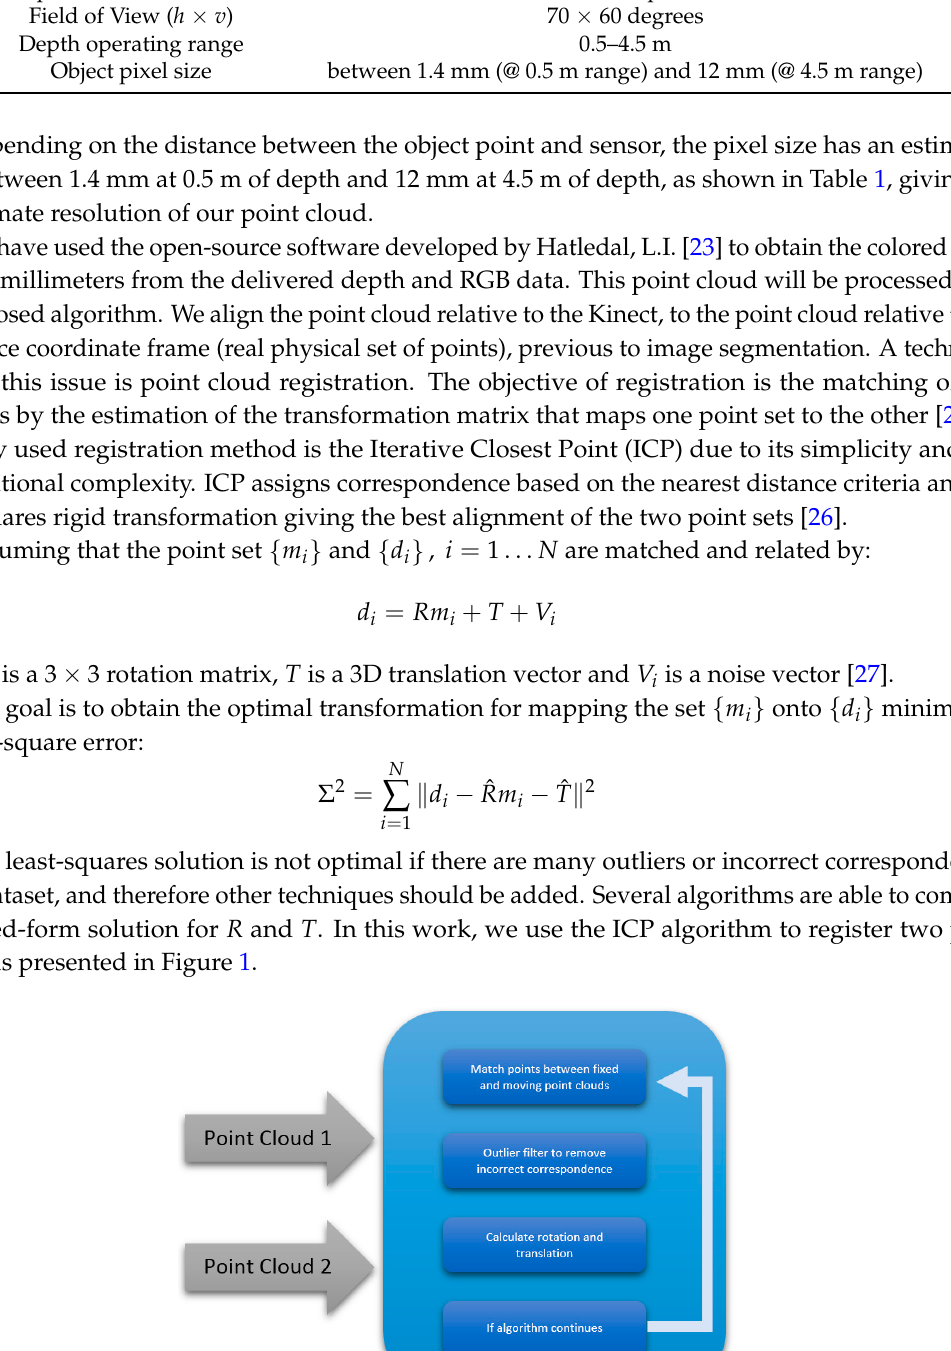
Table 1. Kinect V2 sensor characteristics and specifications. Data from [22].